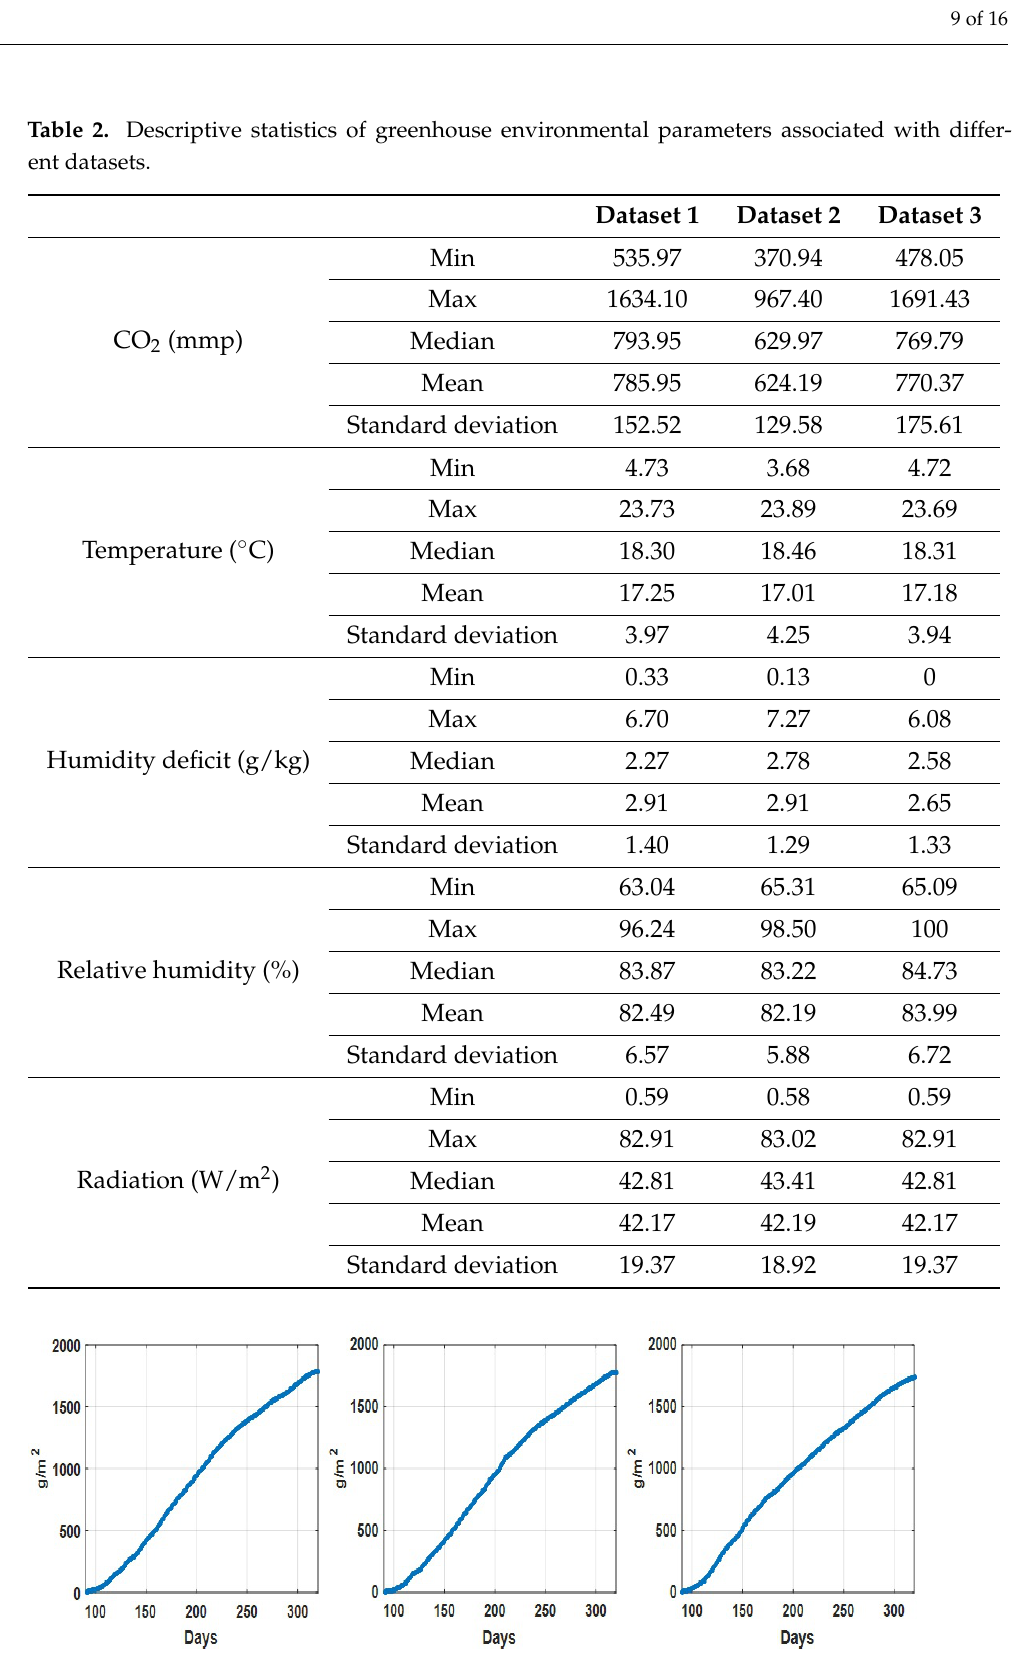
Figure 3. Accumulated tomato fruit yield (g/m 2 ) recorded associate with dataset 1 ( left ), dataset 2 ( middle ) and dataset 3 ( right